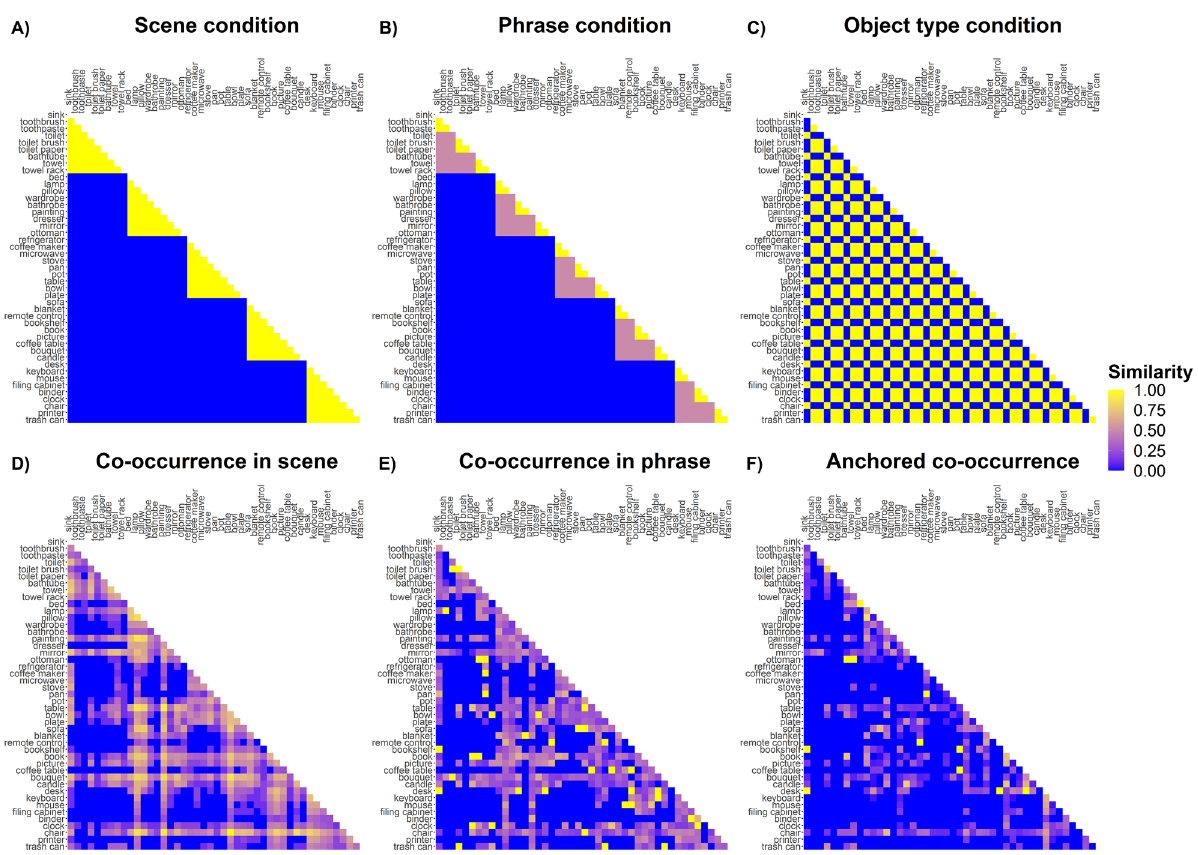
Figure 3. Representational (Dis)similarity matrices (RDMs) for the a priori hierarchical predictors ( A – C ) and for the data-driven hierarchical predictors ( D – F ). RDMs are symmetric matrices where entries on rows and columns are the objects stimuli, and cells represent pairwise similarity along a specific dimension. In ( A – C ), yellow represents pairs of objects that are assigned to the same scene, phrase or type (maximal similarity), while blue represents pairs that are assigned to different scenes, phrases or types (minimal similarity). In ( D ), the log10(counts + 1) of co-occurrence in scene is normalized to span between 0 (blue, few counts) to 1 (yellow, many counts). In ( E ) and ( F ), the colors represent proportion of counts to the total co-occurrence counts of each